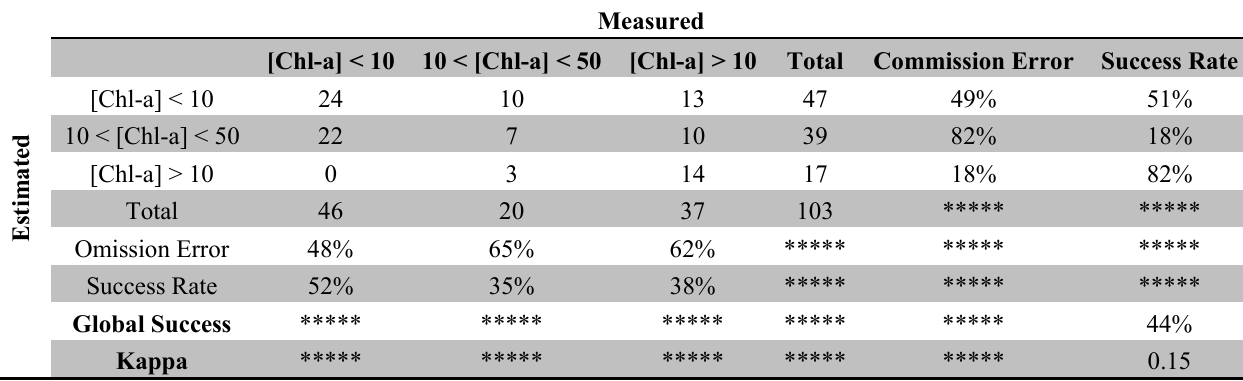
Table 7. The FAI confusion matrix